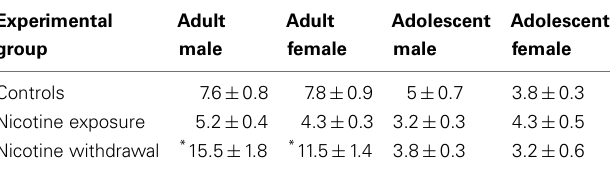
Table 2 | Physical signs of